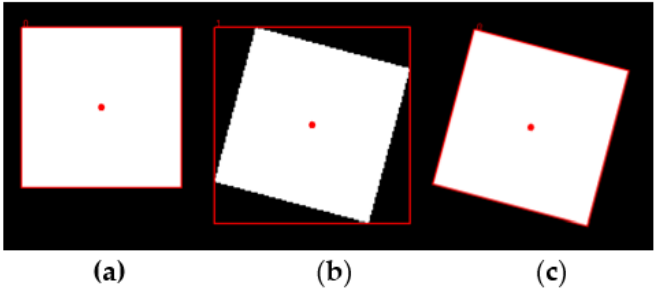
Figure 2. ( a ) Original sample; ( b ) rotated sample and the bounding rectangles estimated by the IMAQ Particle Analysis tool; ( c ) rotated sample and the bounding rectangles estimated by the Python script.